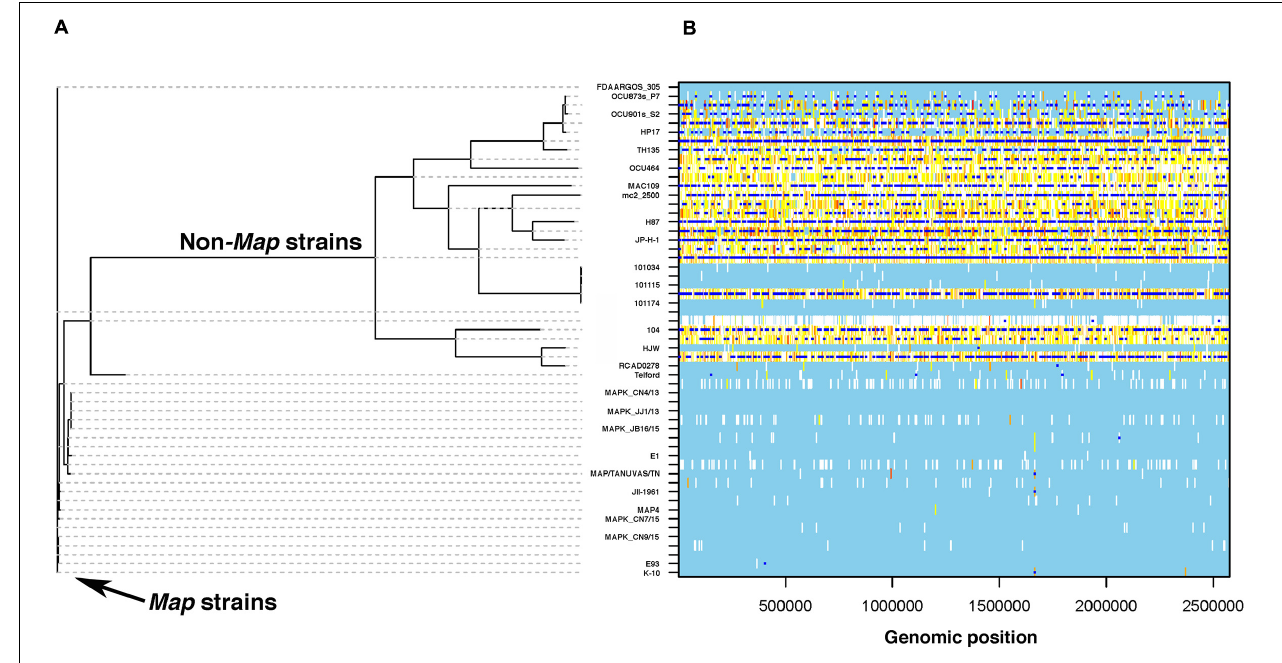
FIGURE 10 | Recombination events detected in M. avium . ClonalFrameML was used with input from the core gene alignment by Roary and RAxML phylogeny to identify recombination induced SNPs and remove them to correct the tree. (A) Core gene phylogeny corrected from inferred recombination events. SNP-inducing homologous recombination due to horizontal gene transfer events in the core genome were removed to correct the true branch lengths on the tree. (B) Representation of recombination events along the genome. The Y -axis corresponds to each branch of the tree in (A) and the X -axis corresponds to the genomic position in the alignment. White vertical lines indicate nucleotide variants (SNPs) compatible with the tree, while dark blue squares represent the location of recombination sites. Note the striking number of dark blue squares in the non- Map strains and their lack in Map strains. Gray dotted lines enable easier connection between the strains shown in (A,B)